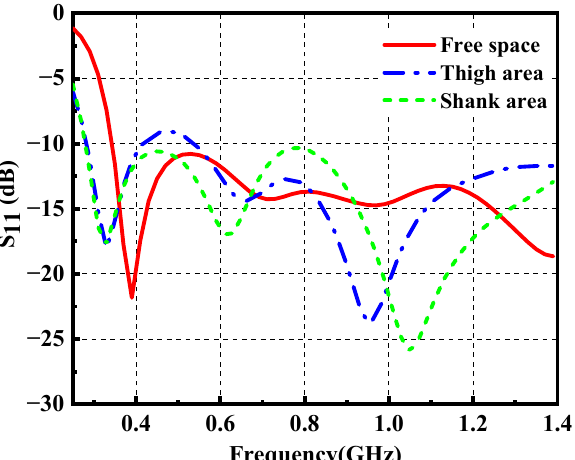
Figure 10. Reflection coefficient of the wearable antenna in free space, thigh area and shank area.